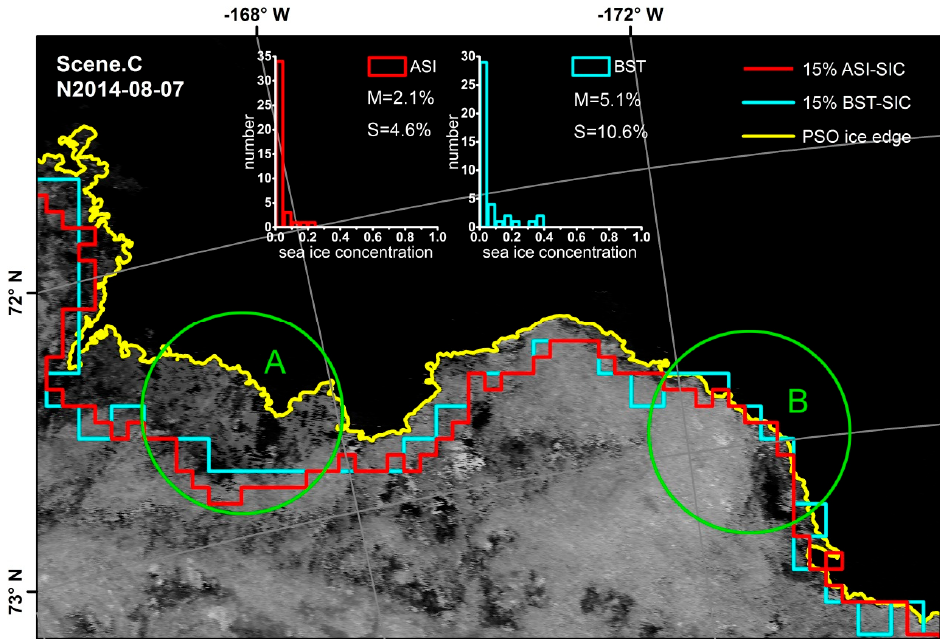
Figure 3. The contour of the 15% ASI ‐ SIC, 15% BST ‐ SIC and the PSO ice edge overlaid on the MOD09GA for the Arctic at 7 August